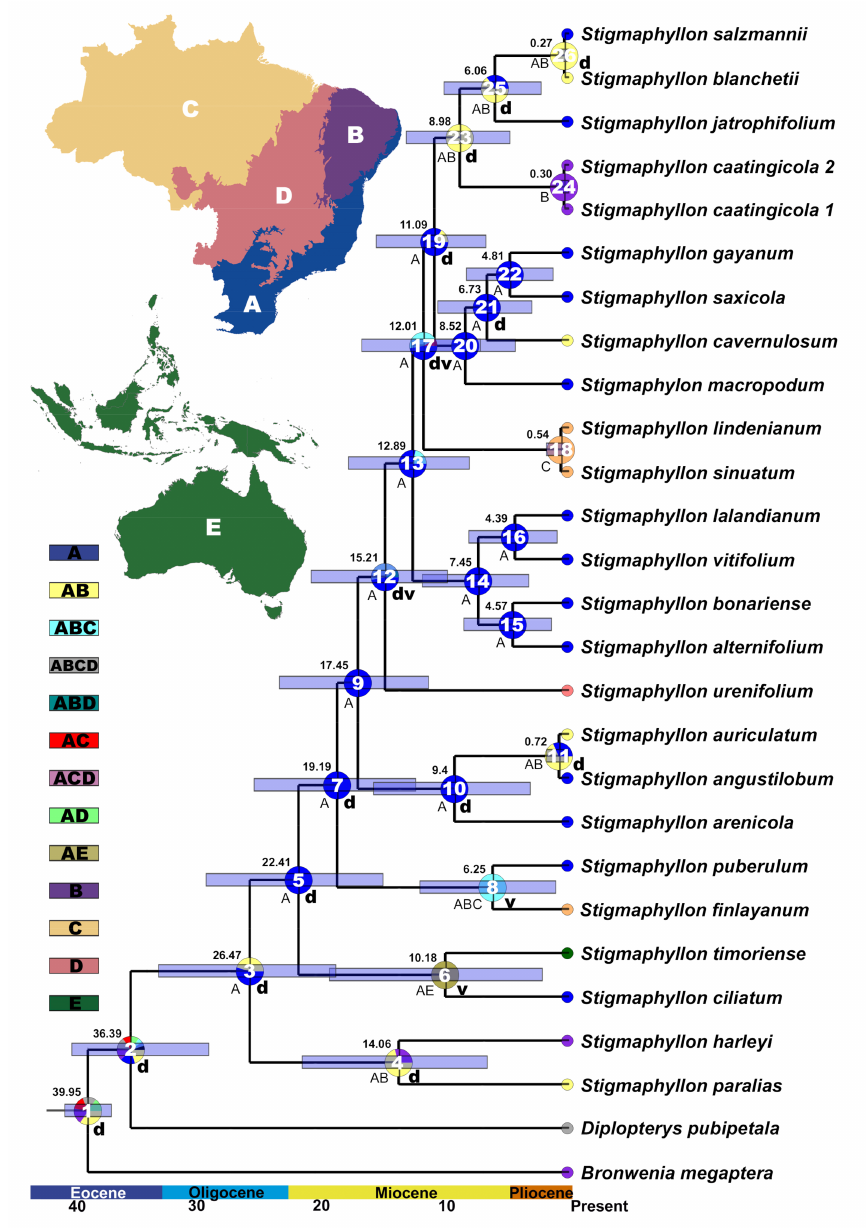
Figure 2. Chronogram and Statistical-Dispersal-Extinction-Cladogenesis (S-DEC) ancestral area reconstructions for Stigmaphyllon . Nodes are numbered from 1 to 26. Numbers above branches represent estimated ages (Mya). Branch letters on the left represent the reconstructed ancestral area(s): ( A ) Atlantic rainforest; ( B ) Seasonally Dry Tropical Forest; ( C ) Amazon rainforest; ( D ) Cerrado; ( E ) Australasian rainforests. Branch letters on the right represent dispersal (d) or vicariant (v)